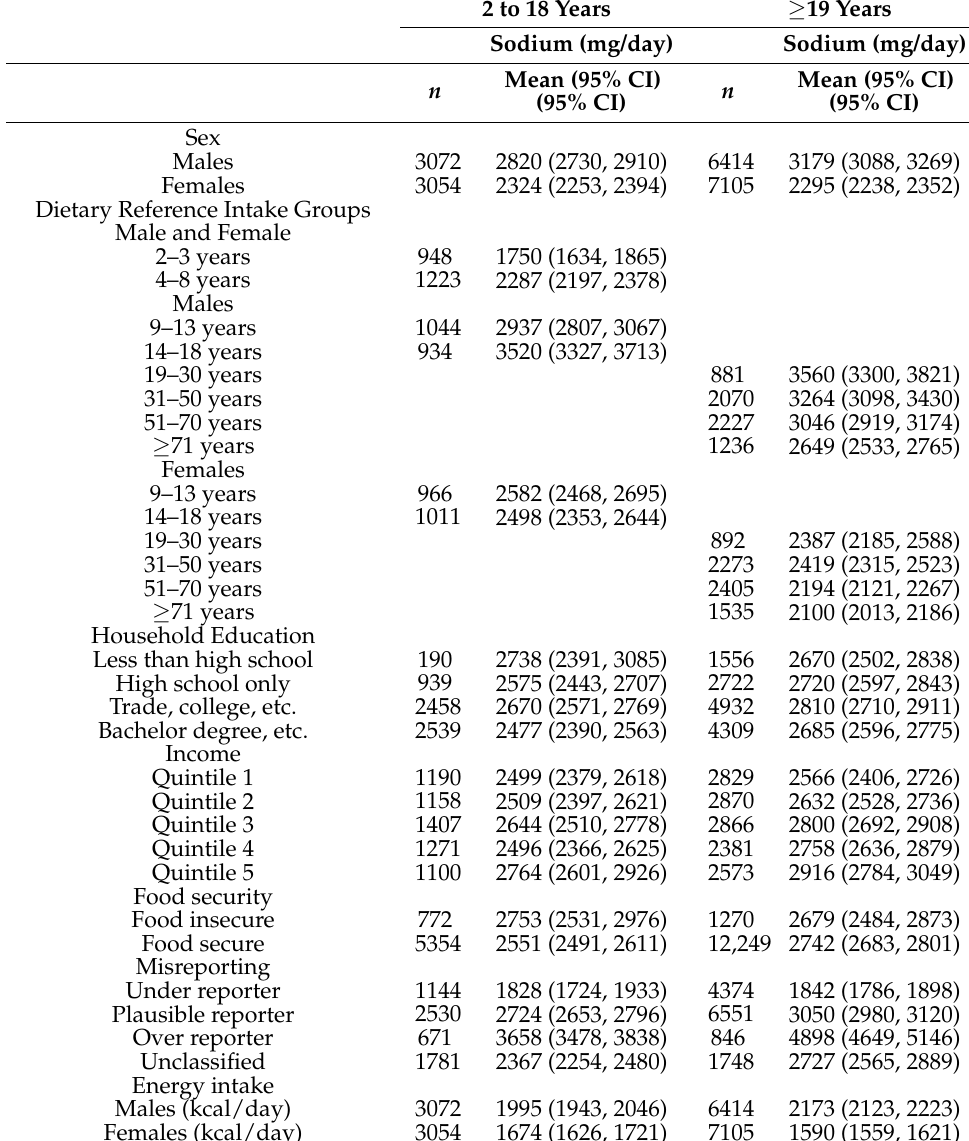
Table 1. Unadjusted weighted mean sodium intake (mg/day) across main study variables in Cana- dians aged 2 to 18 years and 19 years and older in the 2015 Canadian Community Health Survey- Nutrition ( n =